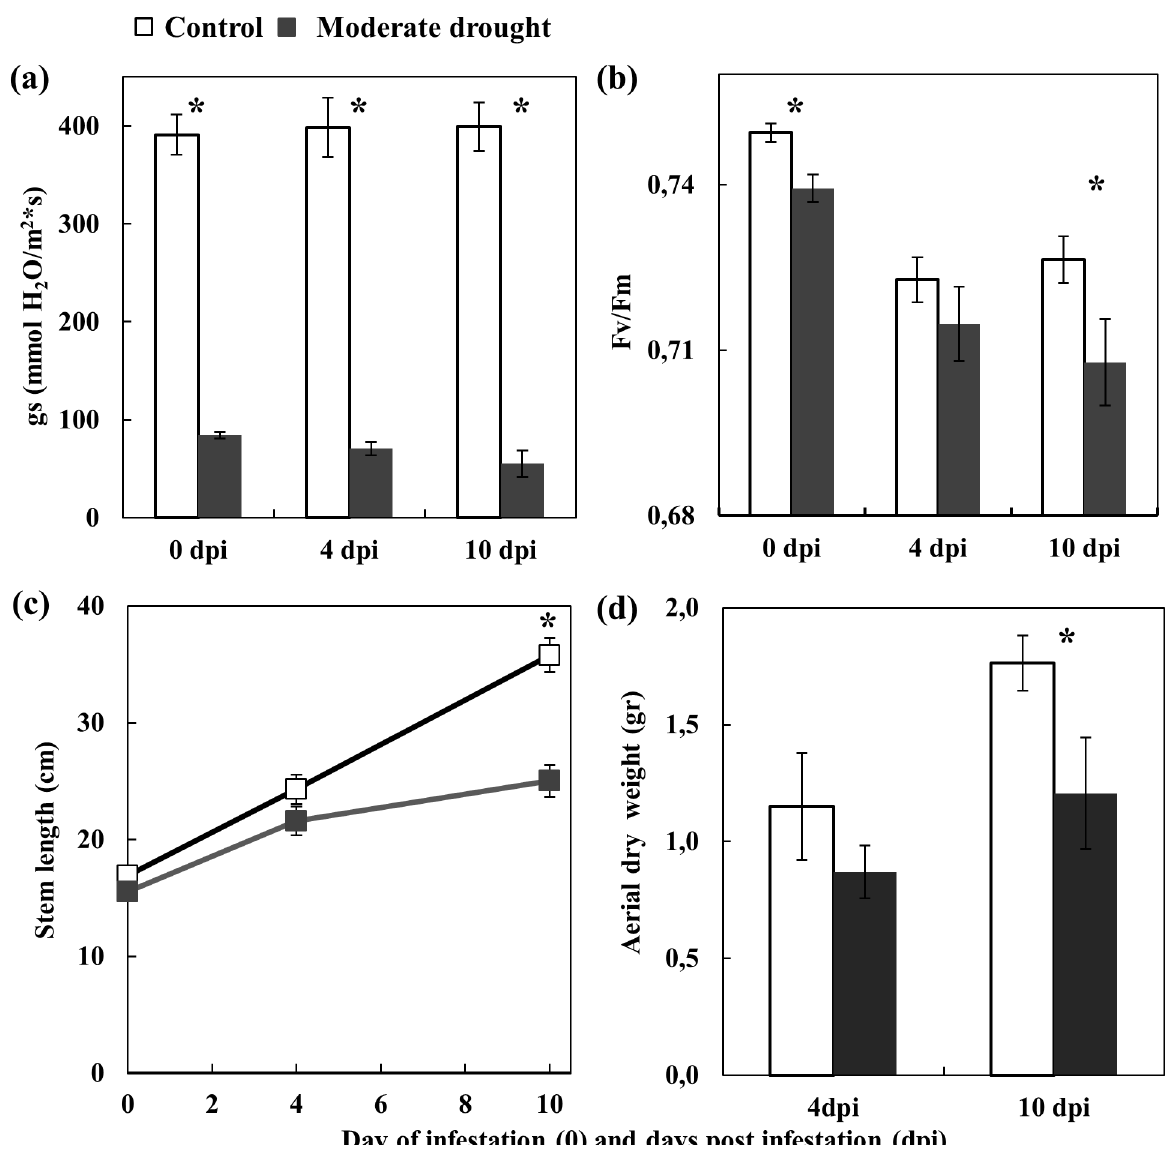
Fig 2. Effect of moderate drought at mite infestation and at 4 and 10 days post infestation (dpi) on: a) tomato stomatal conductance (gs); b) maximum quantum yield of PSII photochemistry (Fv/Fm); c) stem length; d) plant aerial dry weight. Data are mean ± SE. * indicates a statistically significant difference within each time (Three-way ANOVA, Bonferroni post hoc test, P <